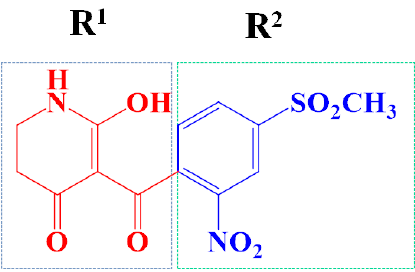
Figure 11. Splitting scheme used to define the two fragments (R 1 —red and R 2 —blue) for developing Topomer CoMFA model of HPPD inhibitors.